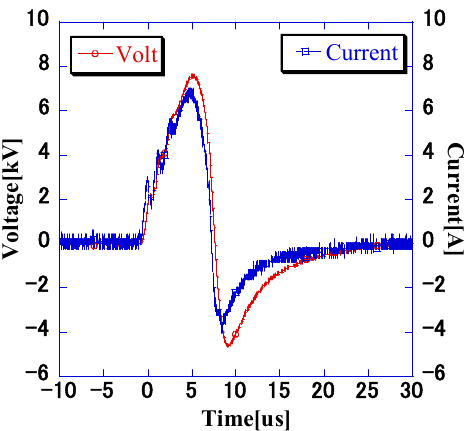
Figure 5. Voltage and current waveforms at a pulse width of 6.9 μ s. The shape of the voltage and current waveforms are similar.